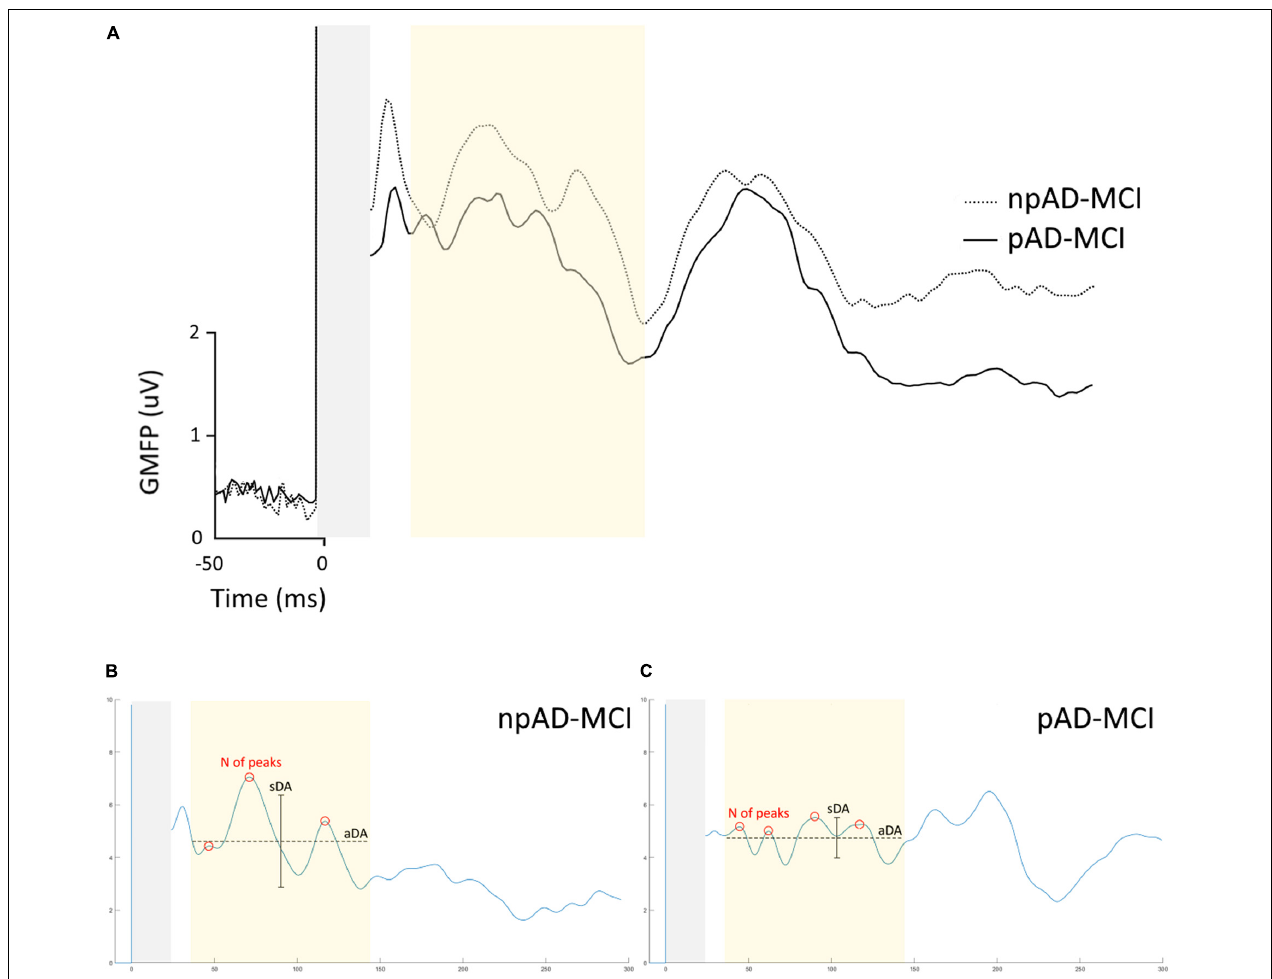
FIGURE 3 | GMFP of pAD-MCI and npAD-MCI groups. (A) Average GMFP waveform in the npAD-MCI and pAD-MCI subgroups. (B,C) The parameters under evaluation, i.e., the number of peaks, the aDA and the sDA are indicated in the time window of interest in the two paradigmatic subjects, one from each subgroup, for visual